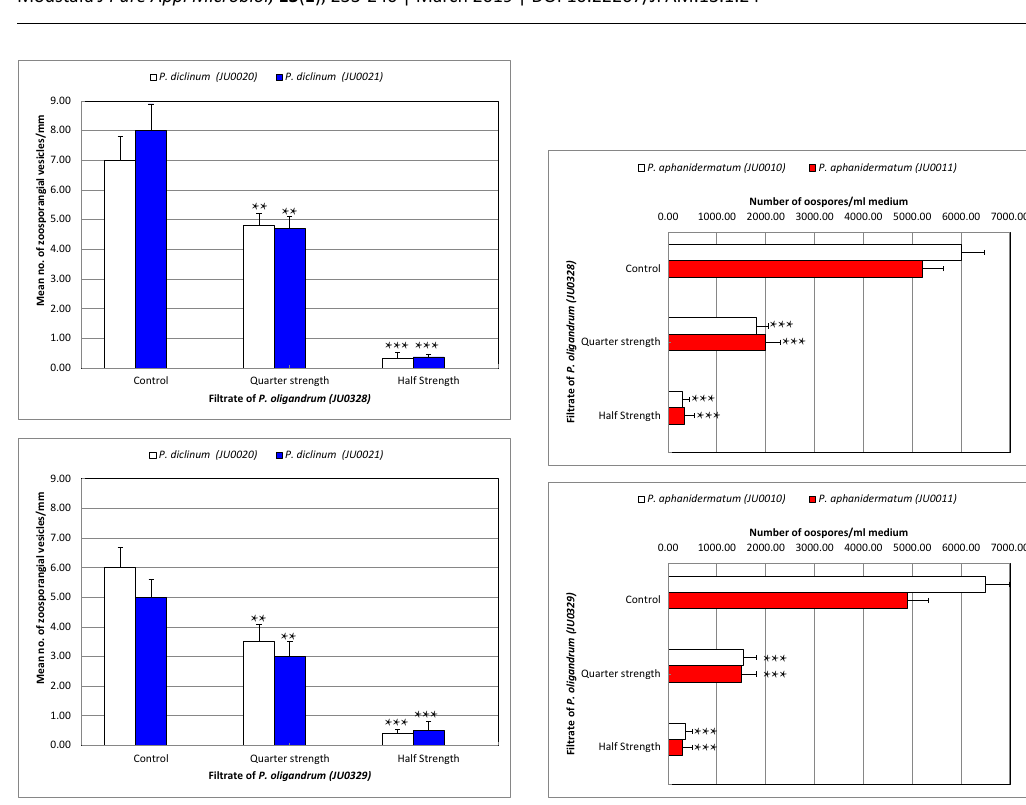
Fig. 2. Effect of cultural filtrate of two isolates of P. oligandrum on zoospore production by two isolates of P. diclinum after 24 h at 20°C in the dark. Bars above all drawing column, represent the standard error of the average data from three replicates and reflect differences between averages of the samples compared to the control sample. Significant values against control represent: ** = highly significant at p < 0.01, *** = very significant at p < 0.001.